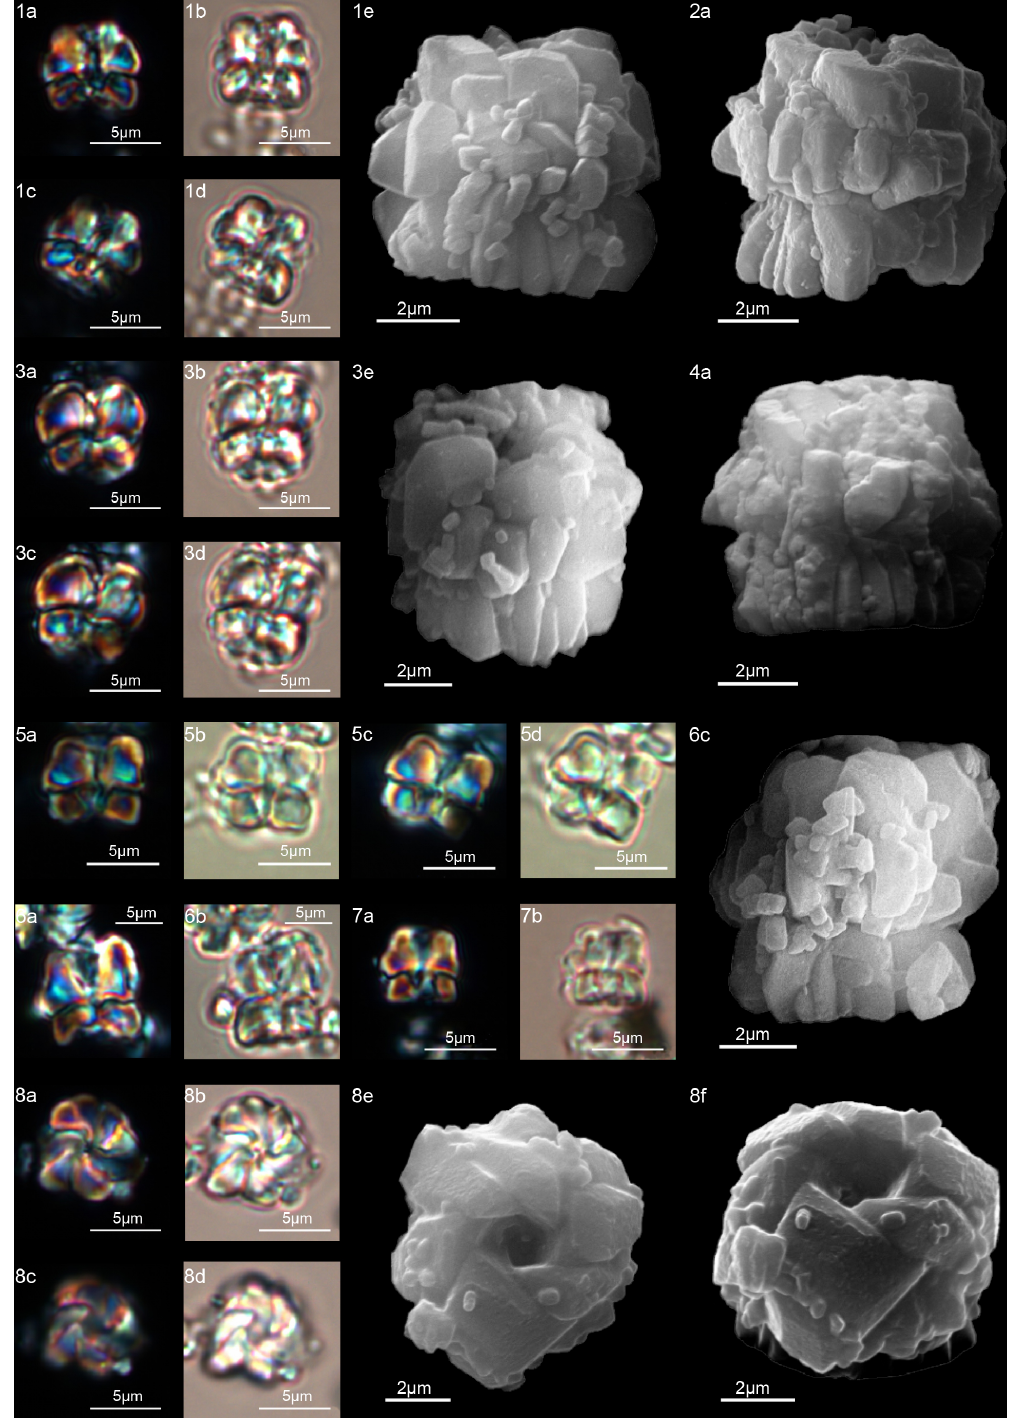
Figure 13. Diantholitha pilula . (1) Holotype (IGF 104335). Sample: 1209C 14-1, 116–117. (1a, c) XPL, (1b, d) PPL, (1e) SEM. (2) Sample: 1262C 11-2, 56–57. (2a) SEM. (3) Sample: 1209C 14-1, 116–117. (3a, c) XPL, (3b, d) PPL, (3e) SEM. (4) Paratype (IGF 104719). Sample: 1262C 11-2, 56–57. (4a) SEM. (5) Sample: 1209C 14-2, 50–51. (5a) XPL, (5b) PPL. (6) Sample: 1209 14-1, 116–117. (6a) XPL, (6b) PPL, (6c) SEM. (7) Sample: 1209C 14-2, 50–51. (7a) XPL, (7b) PPL. (8) Sample: 1209 14-1, 116–117. Distal view. (8a, c) XPL, (8b, d) PPL, (8e) SEM, (8f) SEM rotated 40 ◦ . See Table S1 for sample